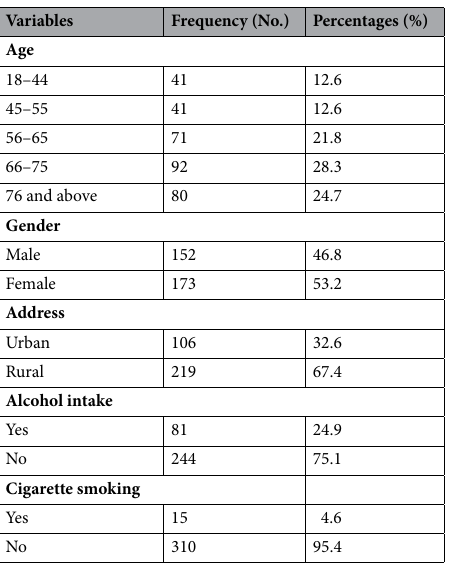
Table 1. Socio-demographic and behavioral characteristics of adult stroke patients admitted to the Stroke Care Unit, University of Gondar hospital, January 1 to December 31, 2020. (n =